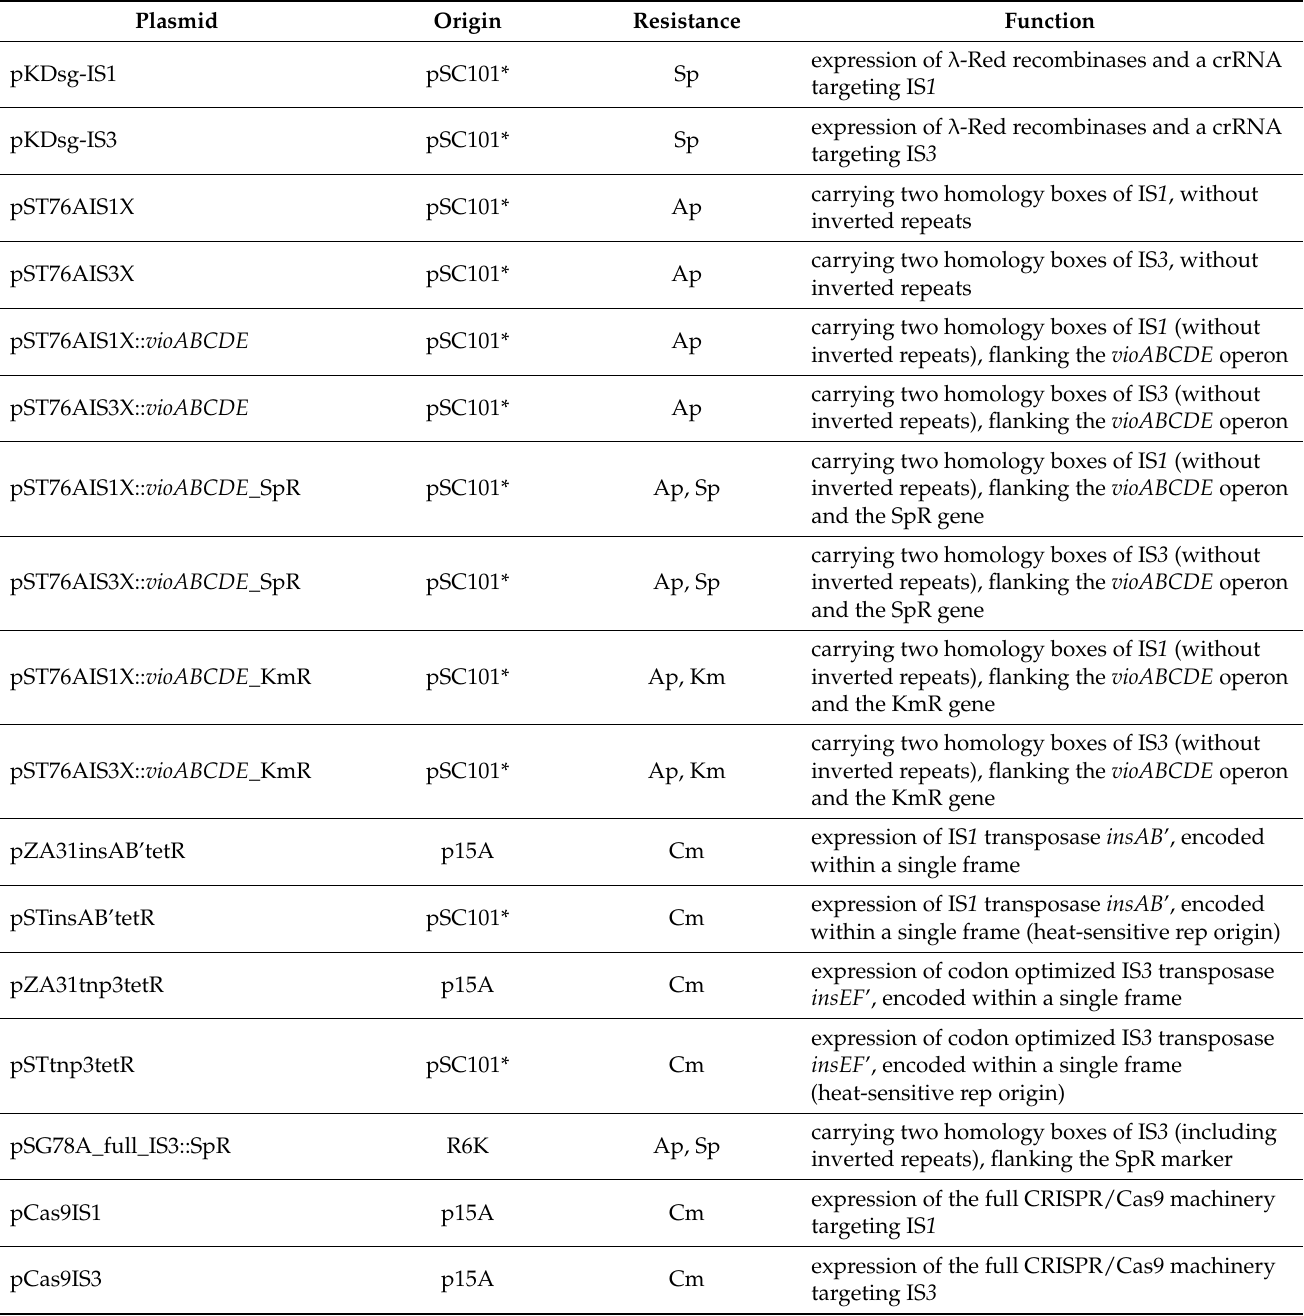
Table 2. Plasmids constructed for this